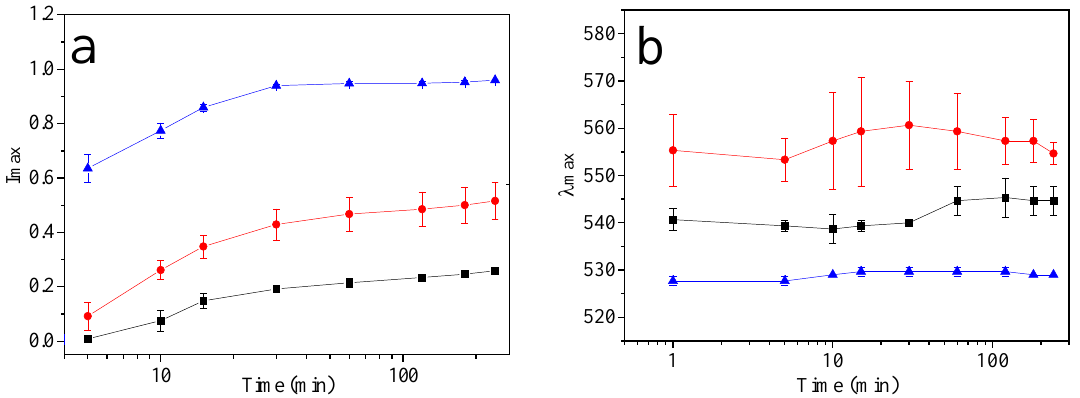
Figure 6. Semilog-plot of ( a ) I max and ( b ) λ max as a function of reaction time for AuNPs synthesized at 30 °C and different Pluronic P103 concentrations (wt%): ( ■ ) AuNPs P103 0.5%; ( ● ) AuNPs P103 1%, and ( ▲ ) AuNPs P103 10%. Solid lines are aids to the eye. Error bars indicate standard deviation for triplicate measurements.